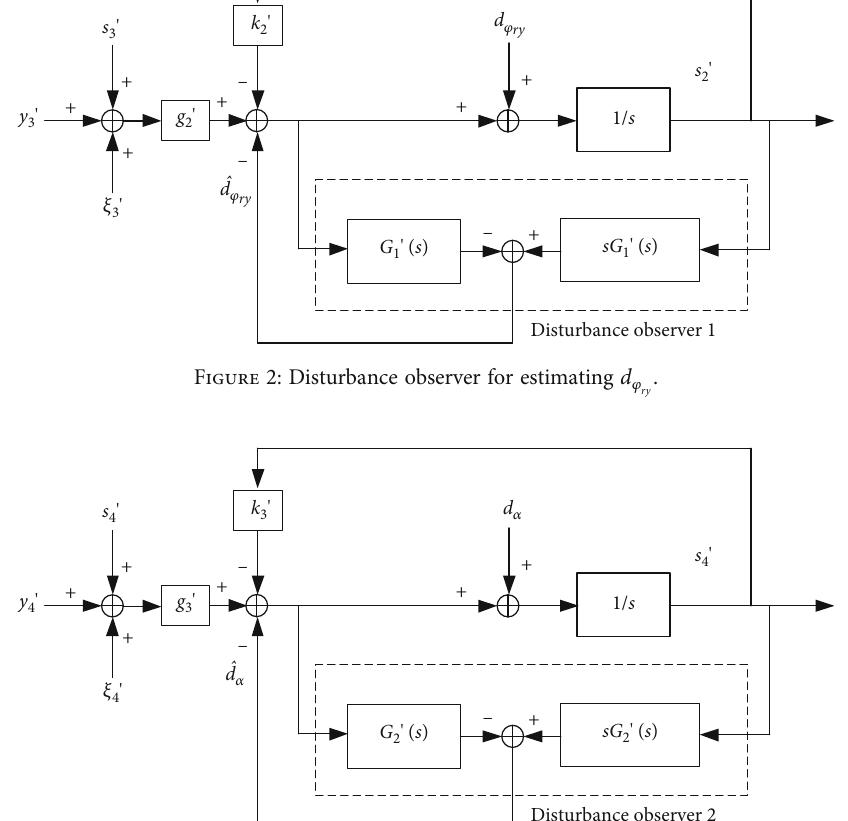
Figure 3: Disturbance observer for estimating d